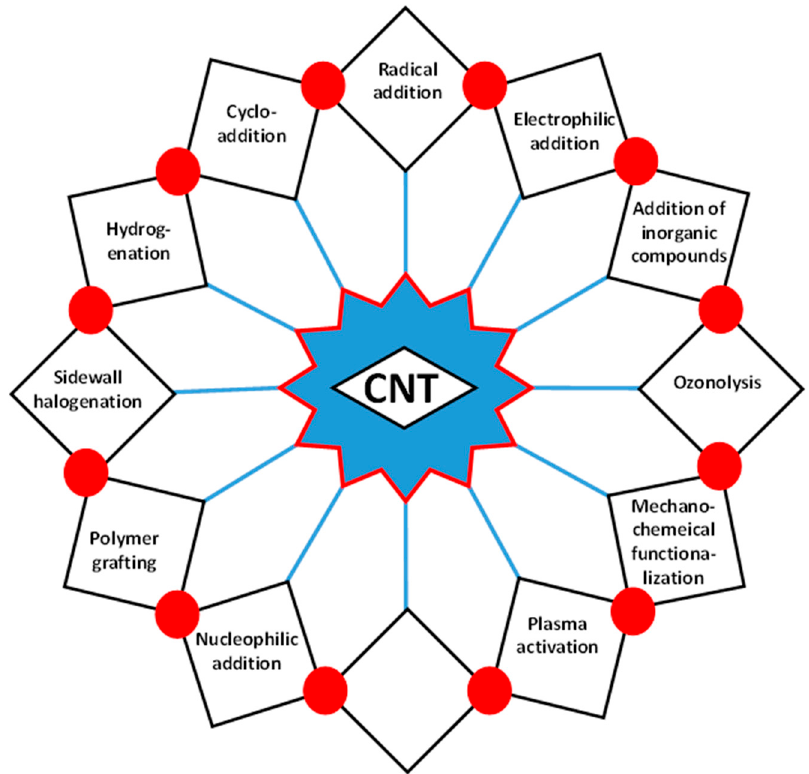
Figure 4. Various types of functionalization of carbon nanotubes.